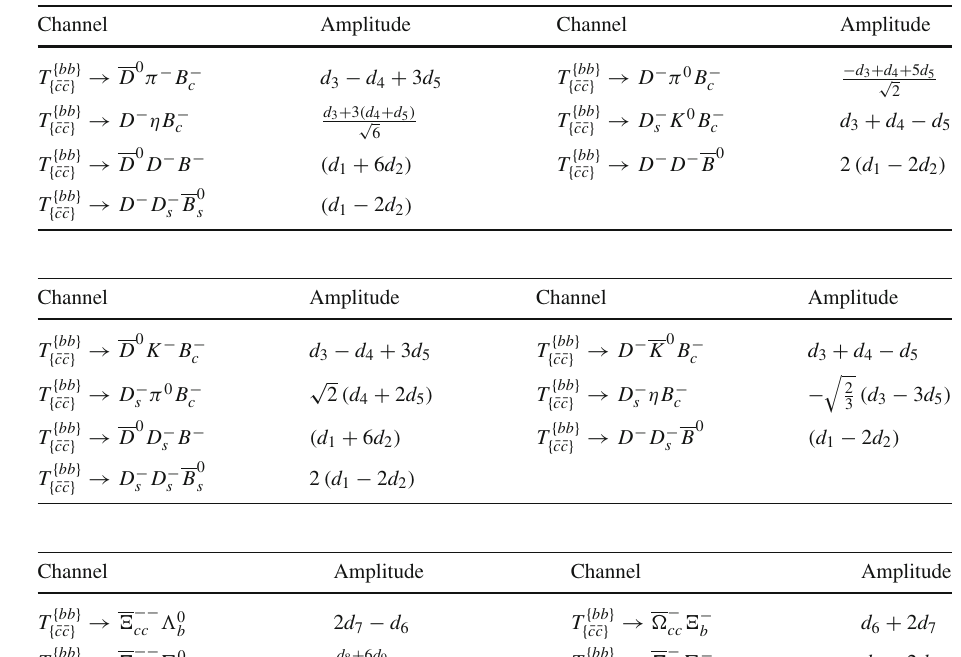
{ bb } Table 8 Tetraquark T Channel Amplitude Channel {¯ c ¯ c } decays into doubly charmed baryon plus singly bottom baryon induced by the charmless b → d transition